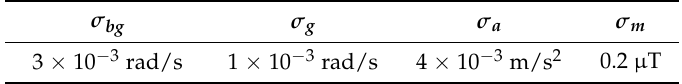
Table 2. Values of measurement noise identified by the Allan’s Variance